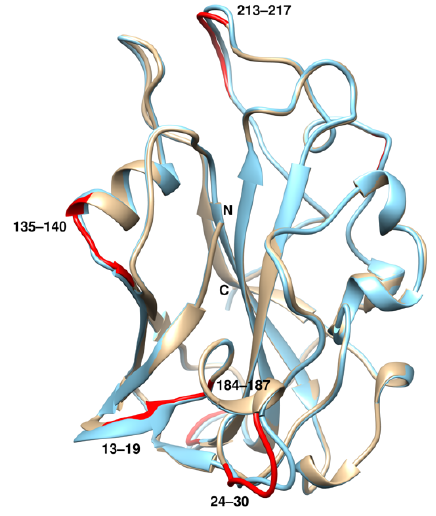
Figure 6. Structural comparison of n Ta AA9A (brown) with r Ta AA9A (cyan). The regions with the highest variations are indicated in red color and labelled.